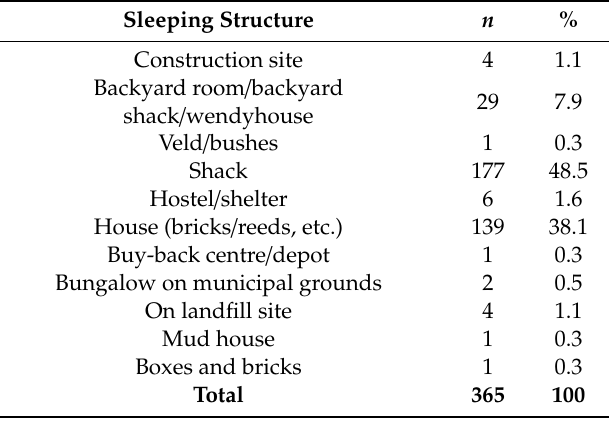
Table 6. Types of structure in which landfill waste pickers sleep ( n =